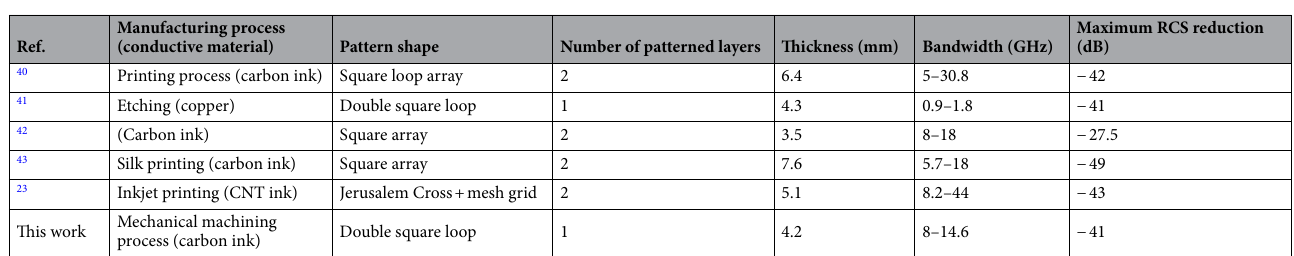
Table 3. Comparison of layer number, pattern shape, thickness, bandwidth, and the maximum RCS reduction with other state-of-art broadband microwave absorbers.